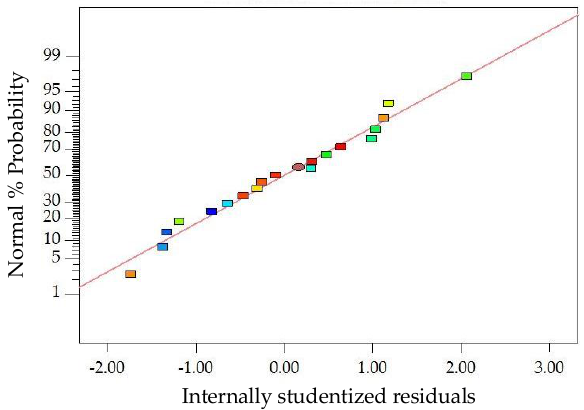
Figure 6. Diagnostics of statistical model: normal plot of residuals for MS .